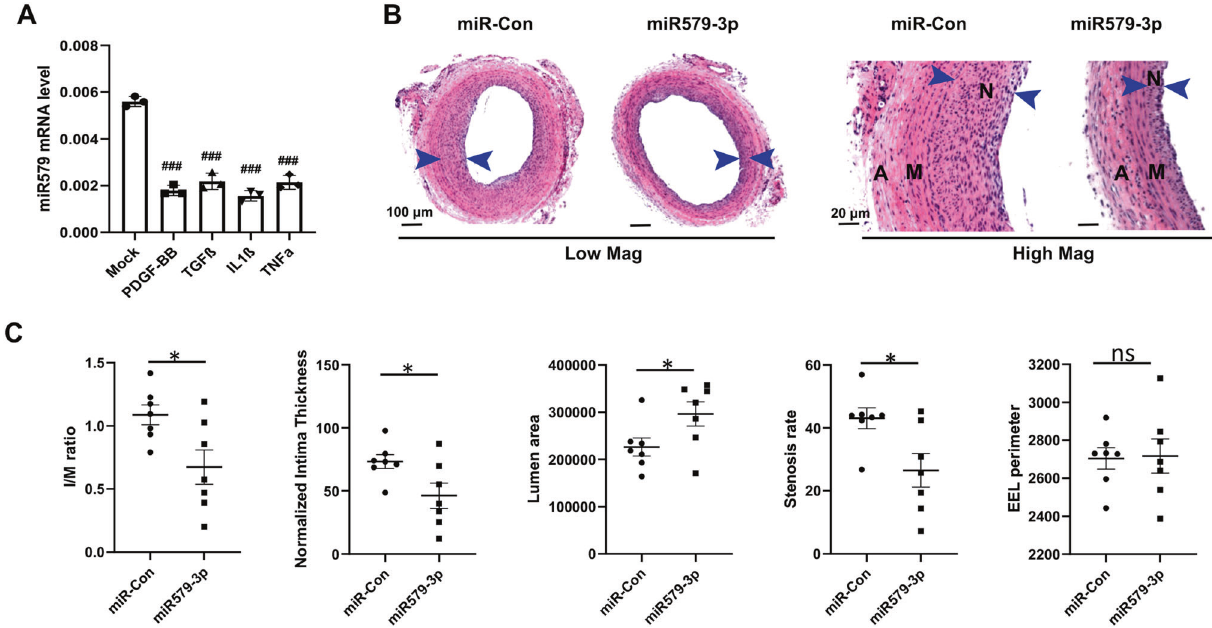
Fig. 1 Treatment of injured rat carotid arteries with miR579-3p-expressing lentivirus inhibits injury-induced IH. A In vitro experiments showing down-regulation of miR579-3p in AoSMCs by a panel of pro-IH cytokines. AoSMCs were starved in basal medium (no FBS) for 24 h and then treated for 24 h without (Mock control) or with a cytokine (50 ng/ml PDGF-BB, 20 ng/mL TGF β 1, 20 ng/ml TNF α , or 10 ng/ml IL1 β ). miR579-3p mRNA was measured by qRT-PCR. Data are presented as mean ± SD ( n = 3 replicates). ### P < 0.001 compared to the Mock control, as analyzed with one ‐ way ANOVA followed by Bonferroni post hoc test. B , C In vivo studies showing inhibition of IH by the treatment with miR579-3p-expressing lentivirus. IH was induced by balloon injury in the rat common carotid artery, and the lentivirus used to express scrambled microRNA or miR579 was locally infused into the injured artery wall. Arteries were collected at post-injury day 14 for histology and morphometric analyses. Representative H&E-stained artery cross ‐ sections are shown in B. A pair of arrows de fi ne the neointima thickness. A, adventitia; M, media; N, neointima. Scale bar: 100 μ m (Low mag.), 20 μ m (High mag). Quantitative morphometric analysis (C): IH = neointima vs media (I/M) area ratio, normalized neointima thickness, lumen area, stenosis rate, and EEL perimeter. The data values of 3 – 4 sections from each animal were averaged. The averages from seven animals in each treatment group were then averaged again to produce mean ± SEM. * p < 0.05, n = 7 rats, unpaired Student ’ s